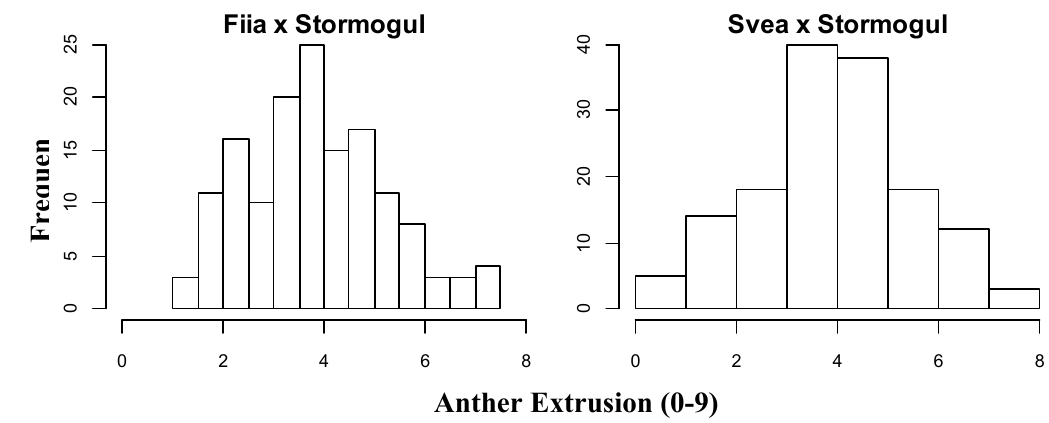
Figure 4. Mean deoxynivalenol content (DON and anther extrusion (AE*, estimated from average number of remaining anthers (AR) using the formula AE = 2.71 (3-AR) ) in a spawn-inoculated field experiment using selected recombinant inbred lines from the Fiia by Stormogul population and the parents.